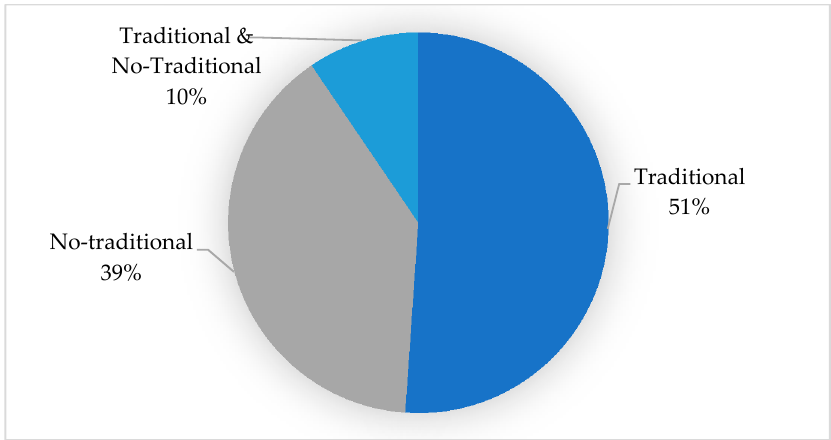
Figure 8. Pedagogical approaches used in ICT-mediated assessment researches.